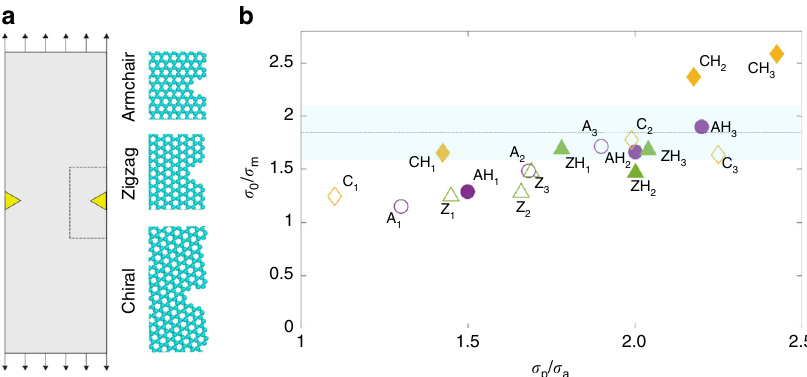
Fig. 4 Molecular dynamics simulations on the fracture of free-standing graphene. a MD simulations of graphene ribbon under tensile tests. Atomic structures of the representative edge defects (dash box in the tensile specimen) are illustrated in the ball-stick models. b The stress ratios measured from the simulation data, where σ 0 is the intrinsic tensile strength of ideal graphene lattice, σ m is the simulation value measured for graphene ribbons with edge defects. σ p and σ a are the peak principal (tensile) stress and average stress in the graphene ribbons. The simulation data is labeled by the name of defects that are summarized in Supplementary Fig. 3. The blue shadowed area in b shows the corresponding ratio of our experimentally measured tensile strengths versus the ideal graphene strength σ